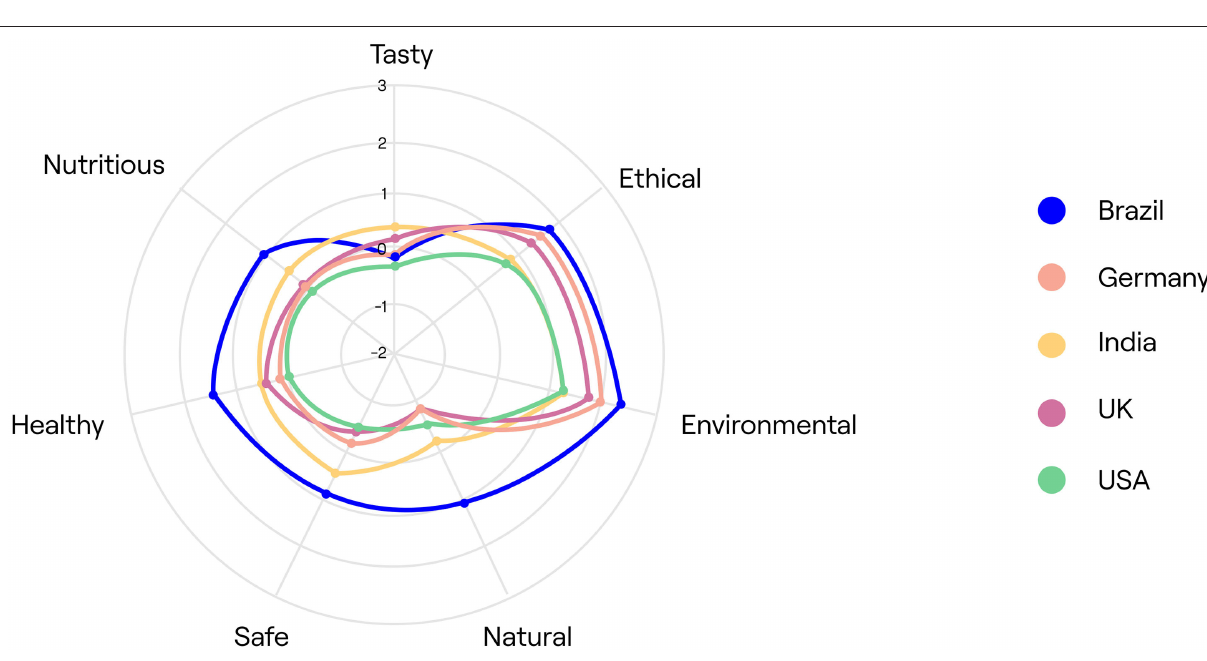
FIGURE 6 | Average difference in rating between basic animal-derived and animal-free cheese from across countries.